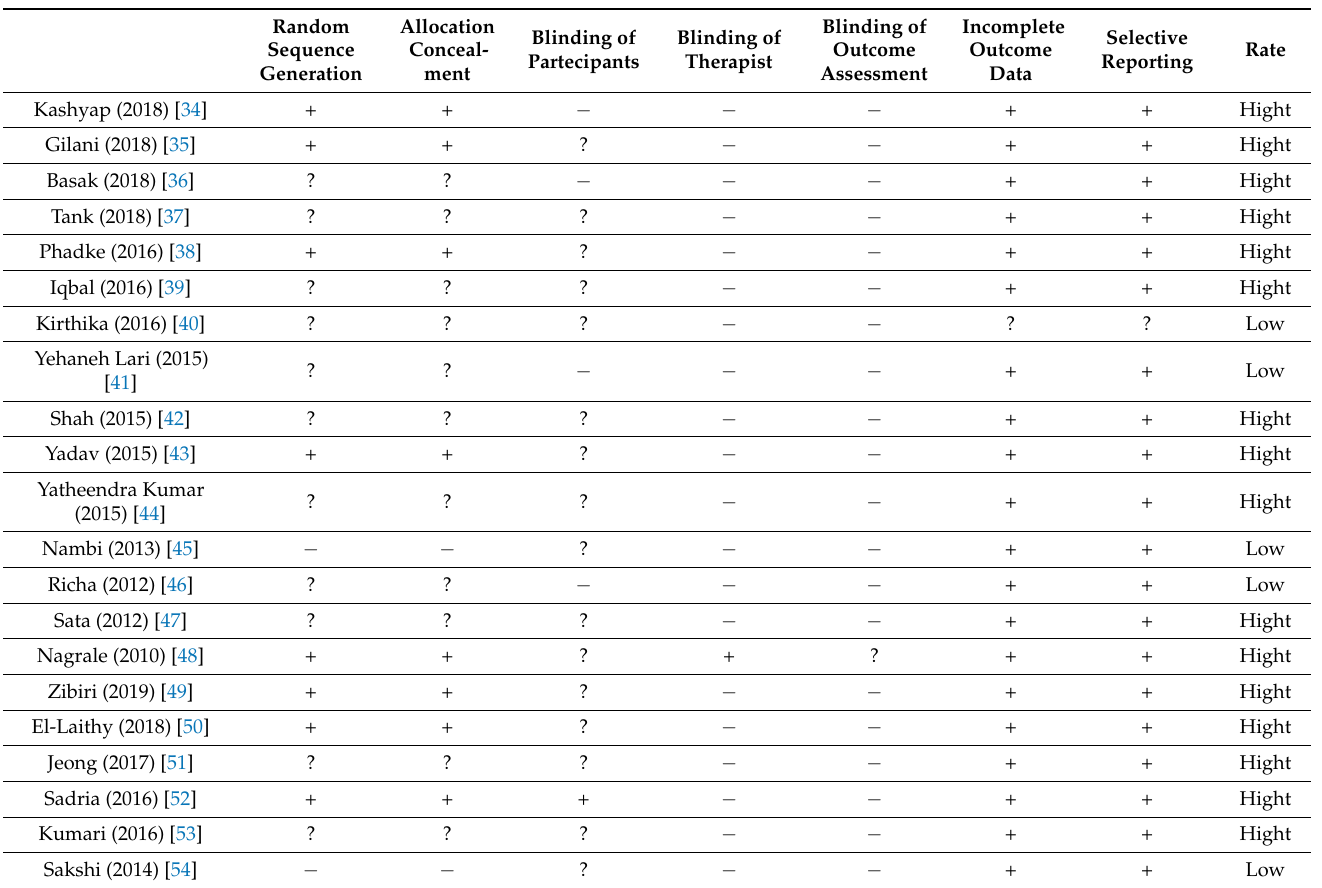
Table 5. Risk of